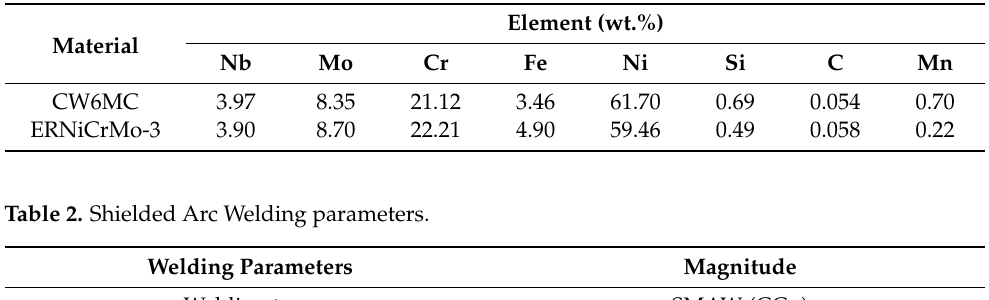
Table 1. Chemical composition of the base metal and filler metal.